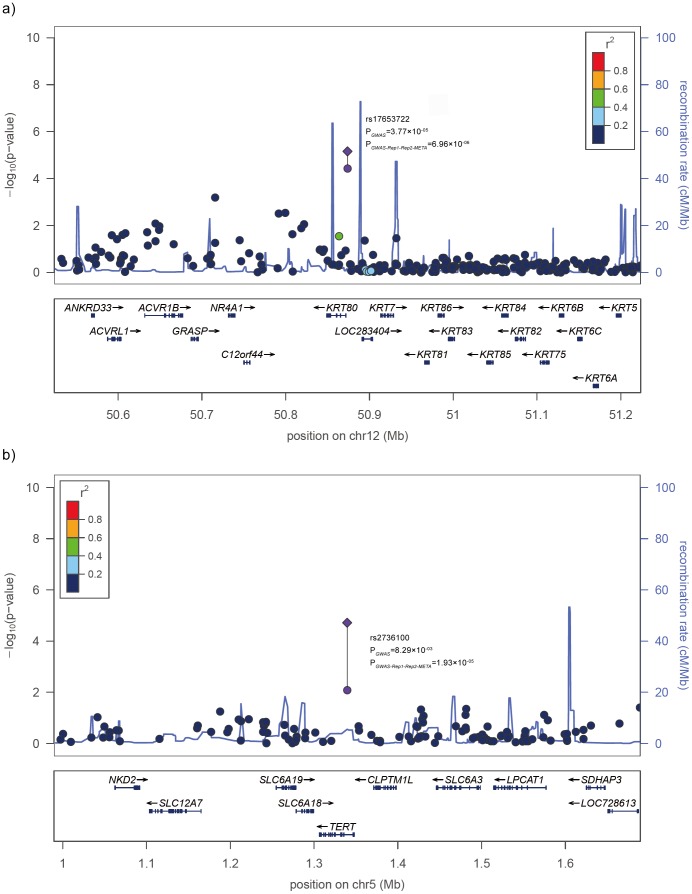
Regional plots of the two loci associated with telomere length.Results are shown for the 12q13.13 (a) and 5p15.33 (b) regions. Top, −log10
P values are shown for SNPs for the region 350 kb on either side of the marker SNPs. P
GWAS is for results obtained from the discovery stage and is shown for genotyped (circle). P
GWAS-Rep1-Rep2 is for results obtained from the combination of the initial and replication study data (diamond). The marker SNP is shown in purple, and the r
2 values of the other SNPs are indicated by color. The genes within the relevant regions are annotated and shown as arrows.